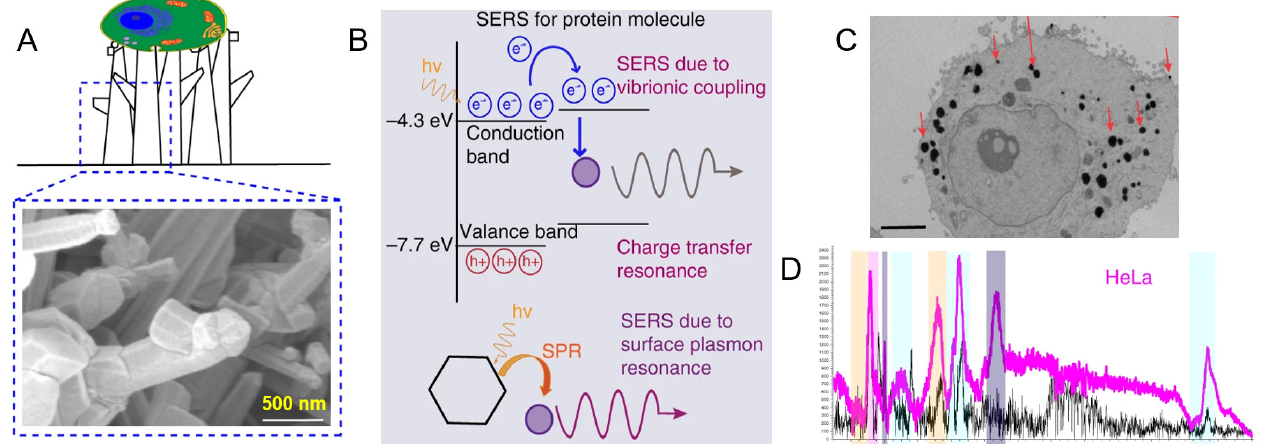
Figure 8. ZnO quantum probes decorated on a 3D platform for a single-cell-level detection [93] ( A ) Three-dimensional tetrapod morphology of the nano-dendrites allowed cells adhesion and proliferation; ( B ) cytoplasm was benefited by the cumulative resonances of charge transfer as well as surface plasmon providing enhanced signals for proteins; ( C ) a TEM image of a cell showing cellular uptake and internalization of the quantum probe, Scale bar = 5 µm; ( D ) enhanced SERS signal for HeLa cells.